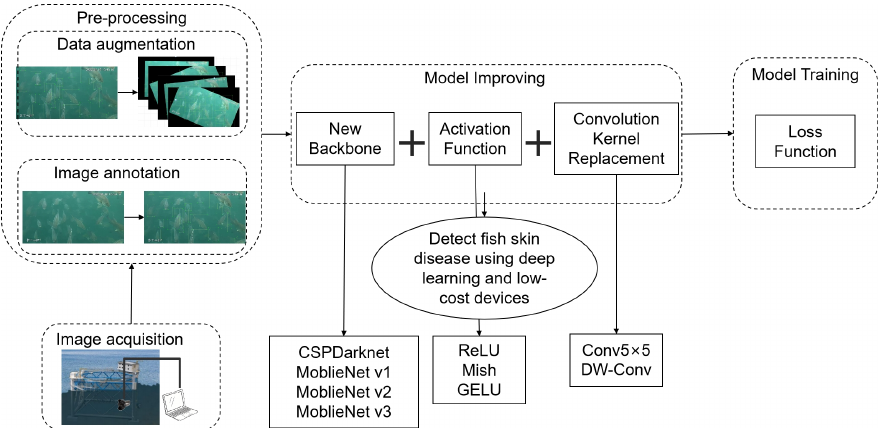
Figure 2. Schematic diagram of image-acquisition system, image preprocessing, model improving, model training, and fish skin disease detection.